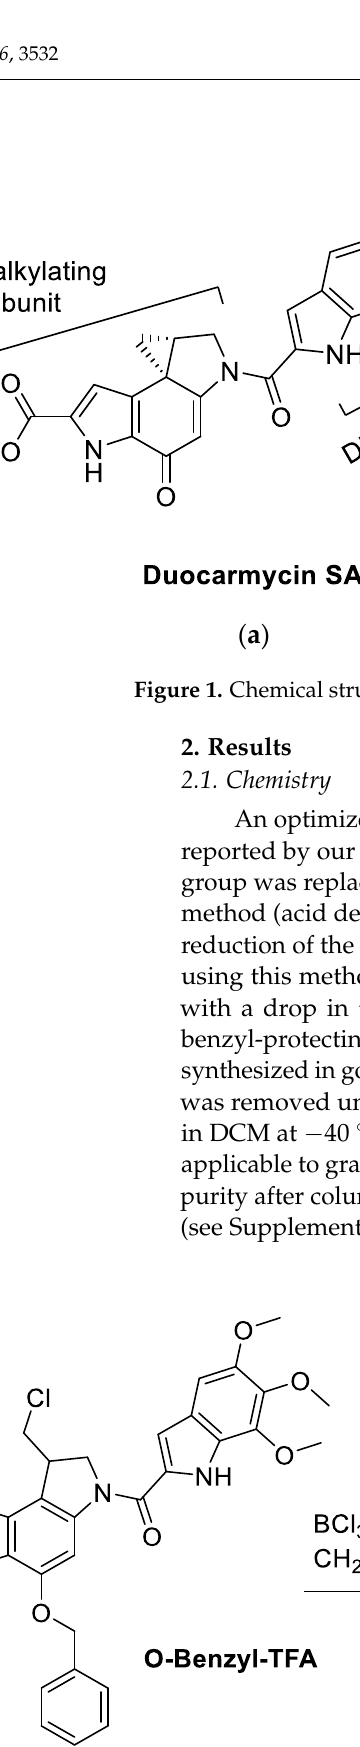
Figure 1. Chemical structure of ( a ) duocarmycin SA and ( b ) tafuramycin